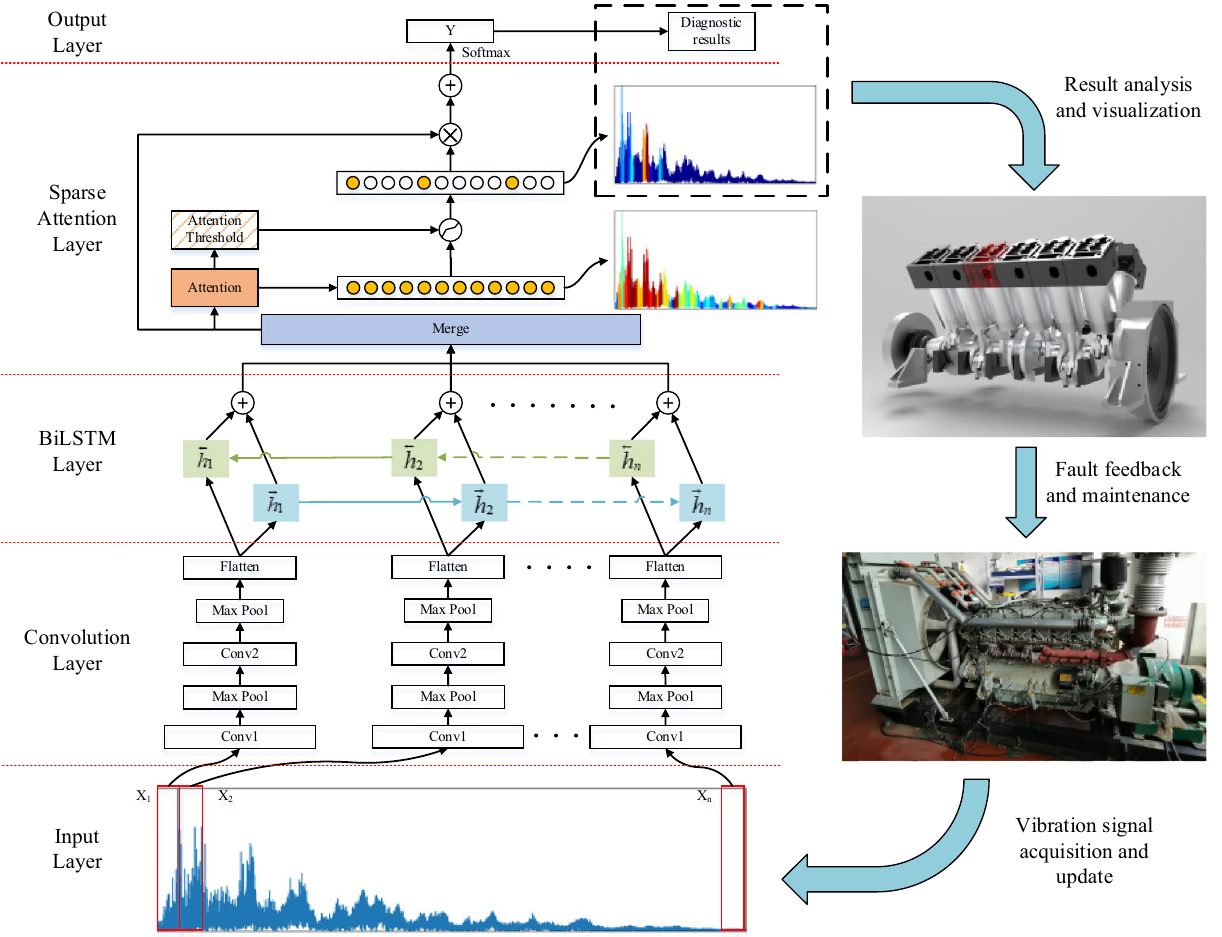
Figure 3. Fault diagnosis process of digital twin based on adaptive sparse attention